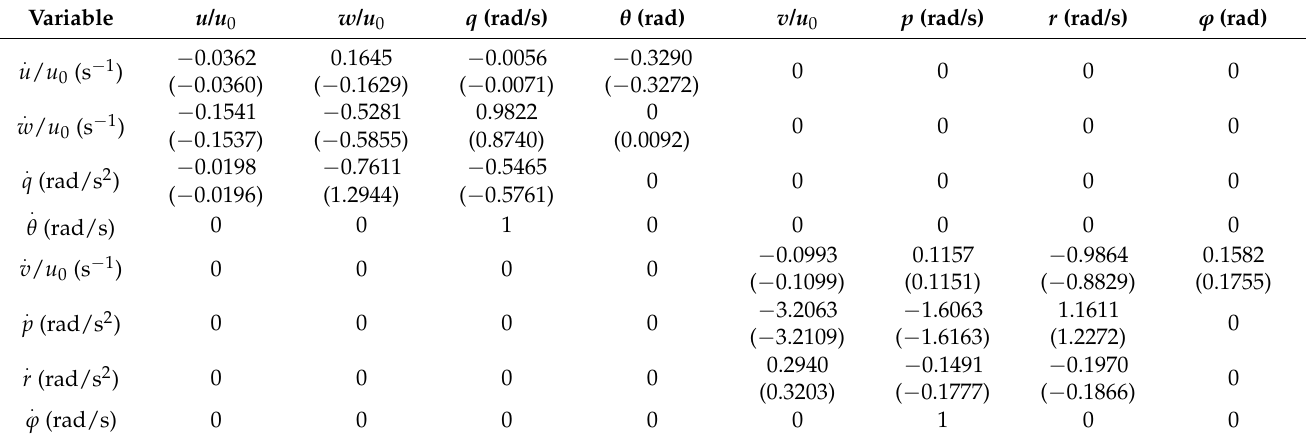
Table 12. CFD–RANS (extrapolated) 8 × 8 stability matrix for flight condition 5 in Tables 4 and 5.